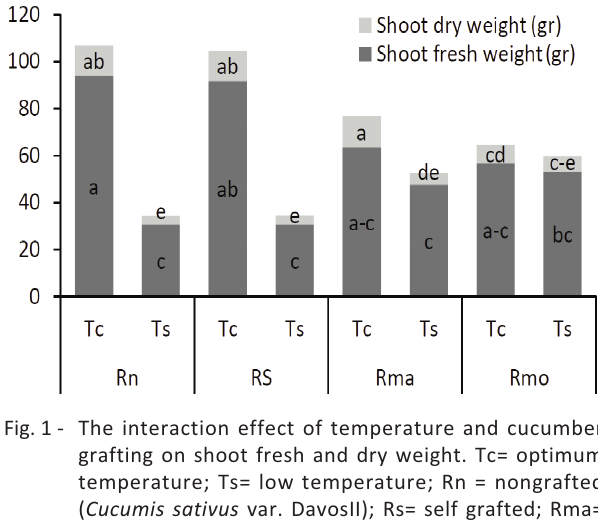
Fig. 1 ­ The interaction effect of temperature and cucumber grafting on shoot fresh and dry weight. Tc= optimum temperature; Ts= low temperature; Rn = nongrafted ( Cucumis sativus var. DavosII); Rs= self grafted; Rma= Cucurbita maxima ; Rmo= Momordica charantia .